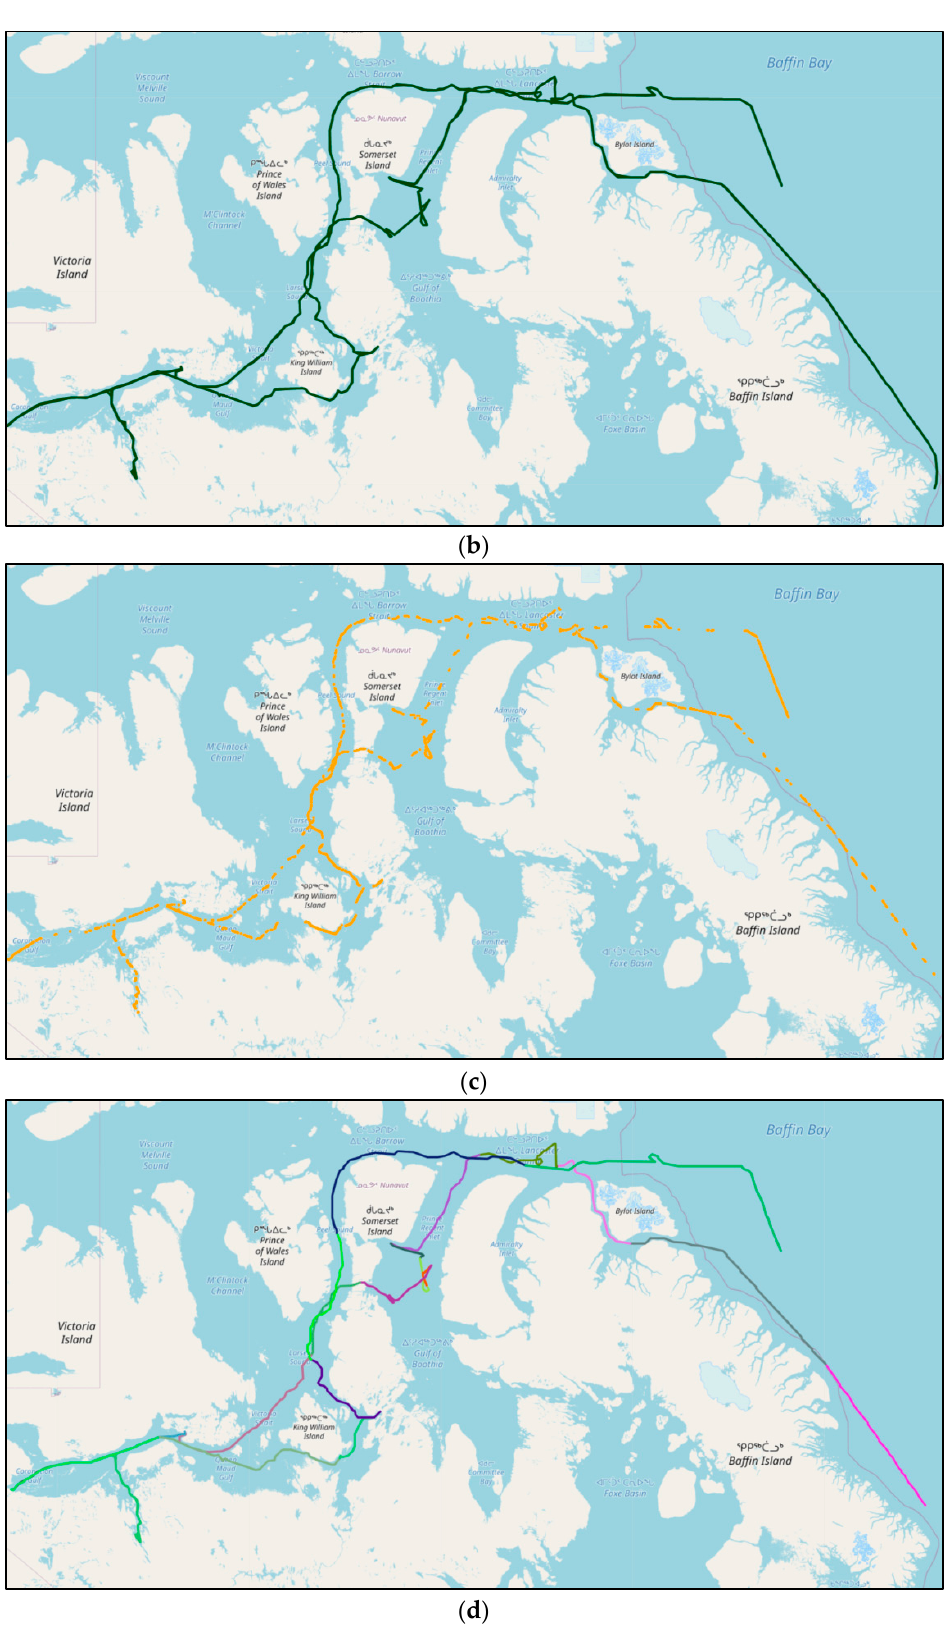
Figure 12. Comparison of denoising effects of MMSI 316025029. ( a ) The raw AIS trajectory; ( b ) the results after simple data preprocessing; ( c ) the point data before reconstruction; ( d ) the results reconstructed trajectories (different colours represent the ship trajectories on 23 days).